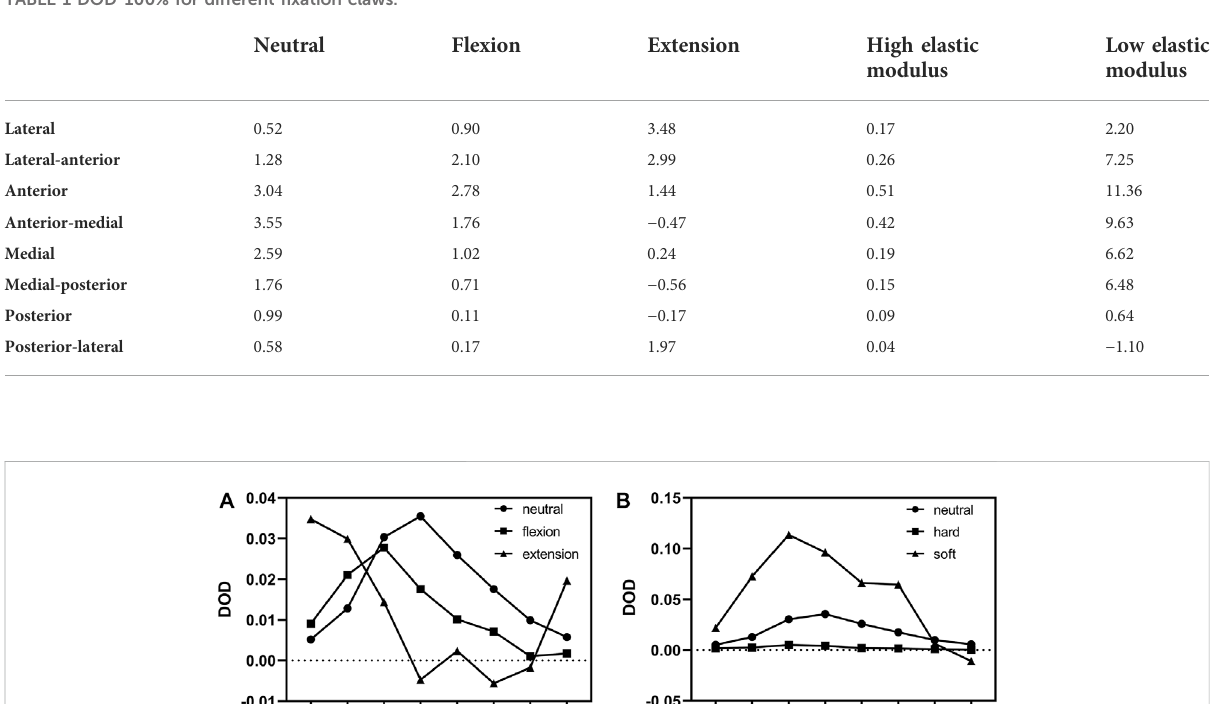
TABLE 1 DOD*100% for different fi xation claws.